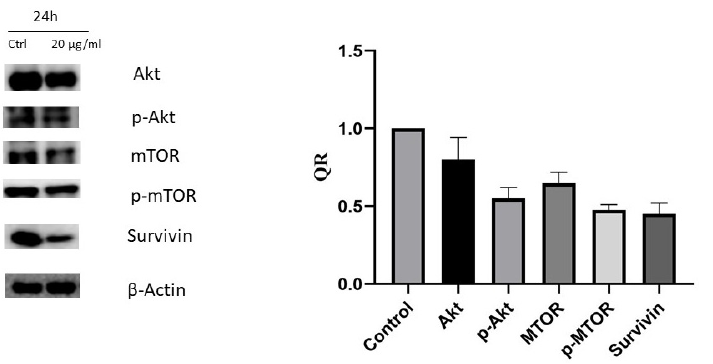
Figure 6. The effect of the carnosic acid on protein expression of AKT1, Phospho-AKT-S473, mTOR, Phospho-mTOR-S2448, and survivin analyzed by Western blotting. The cells were treated with vehicle (0.1% DMSO) or treated with carnosic acid at 20 µg/mL for 24 h. The quantitative analysis of each band density after normalization to the control is represented by QR.